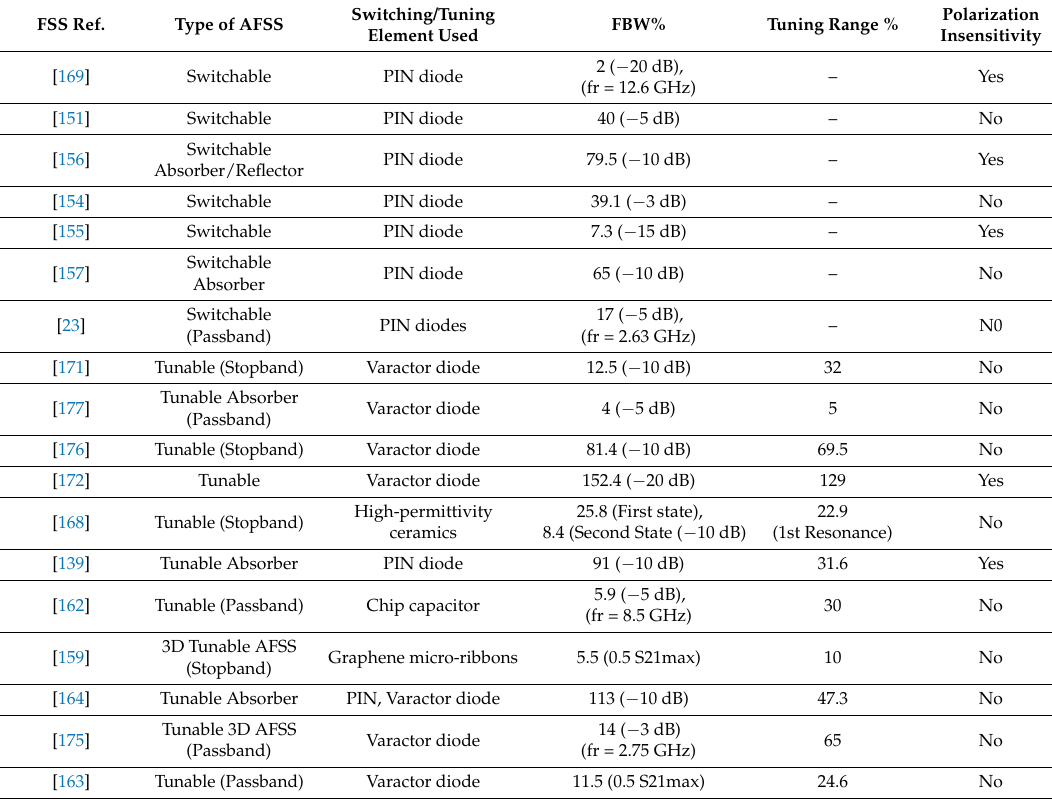
Table 9. An overview of types of AFSS with the comparison of their FBW and tuning range (TRs). FSS